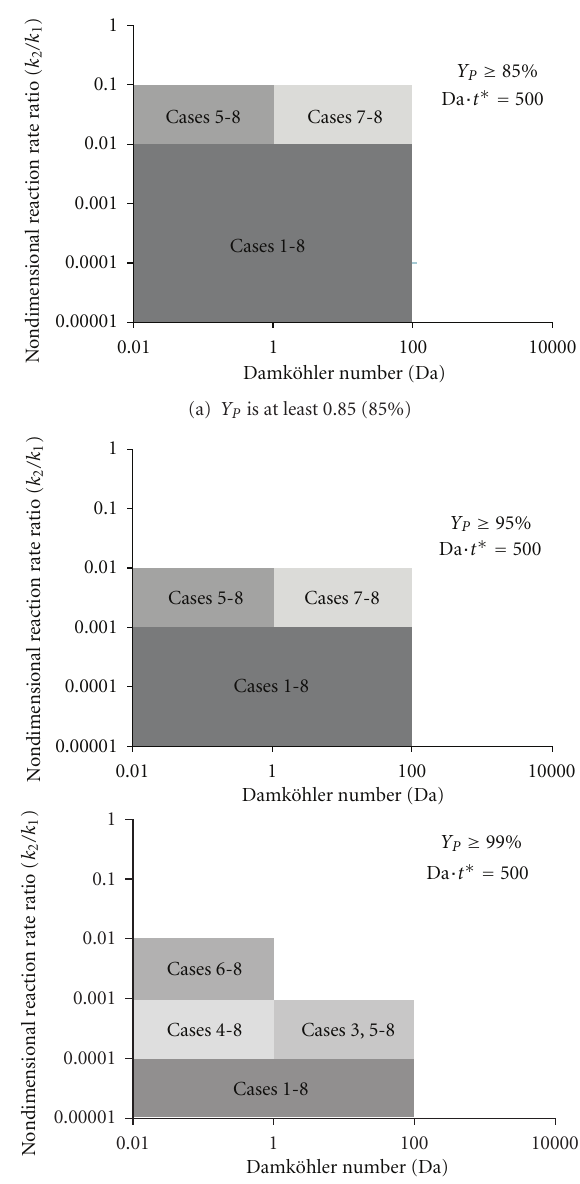
Figure 10: Design spaces for yield of P for Da and k k · t ∗ = 500 for C-C 2 / 1 at Da